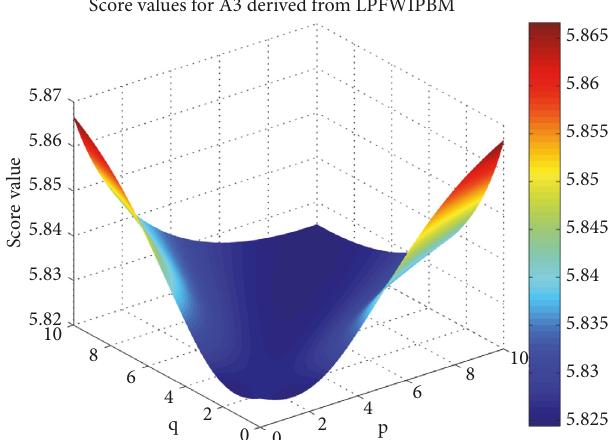
Figure 4: Score values of alternative A3 derived from LPFWIPBM when 𝑝, 𝑞 ∈ (0,10) .